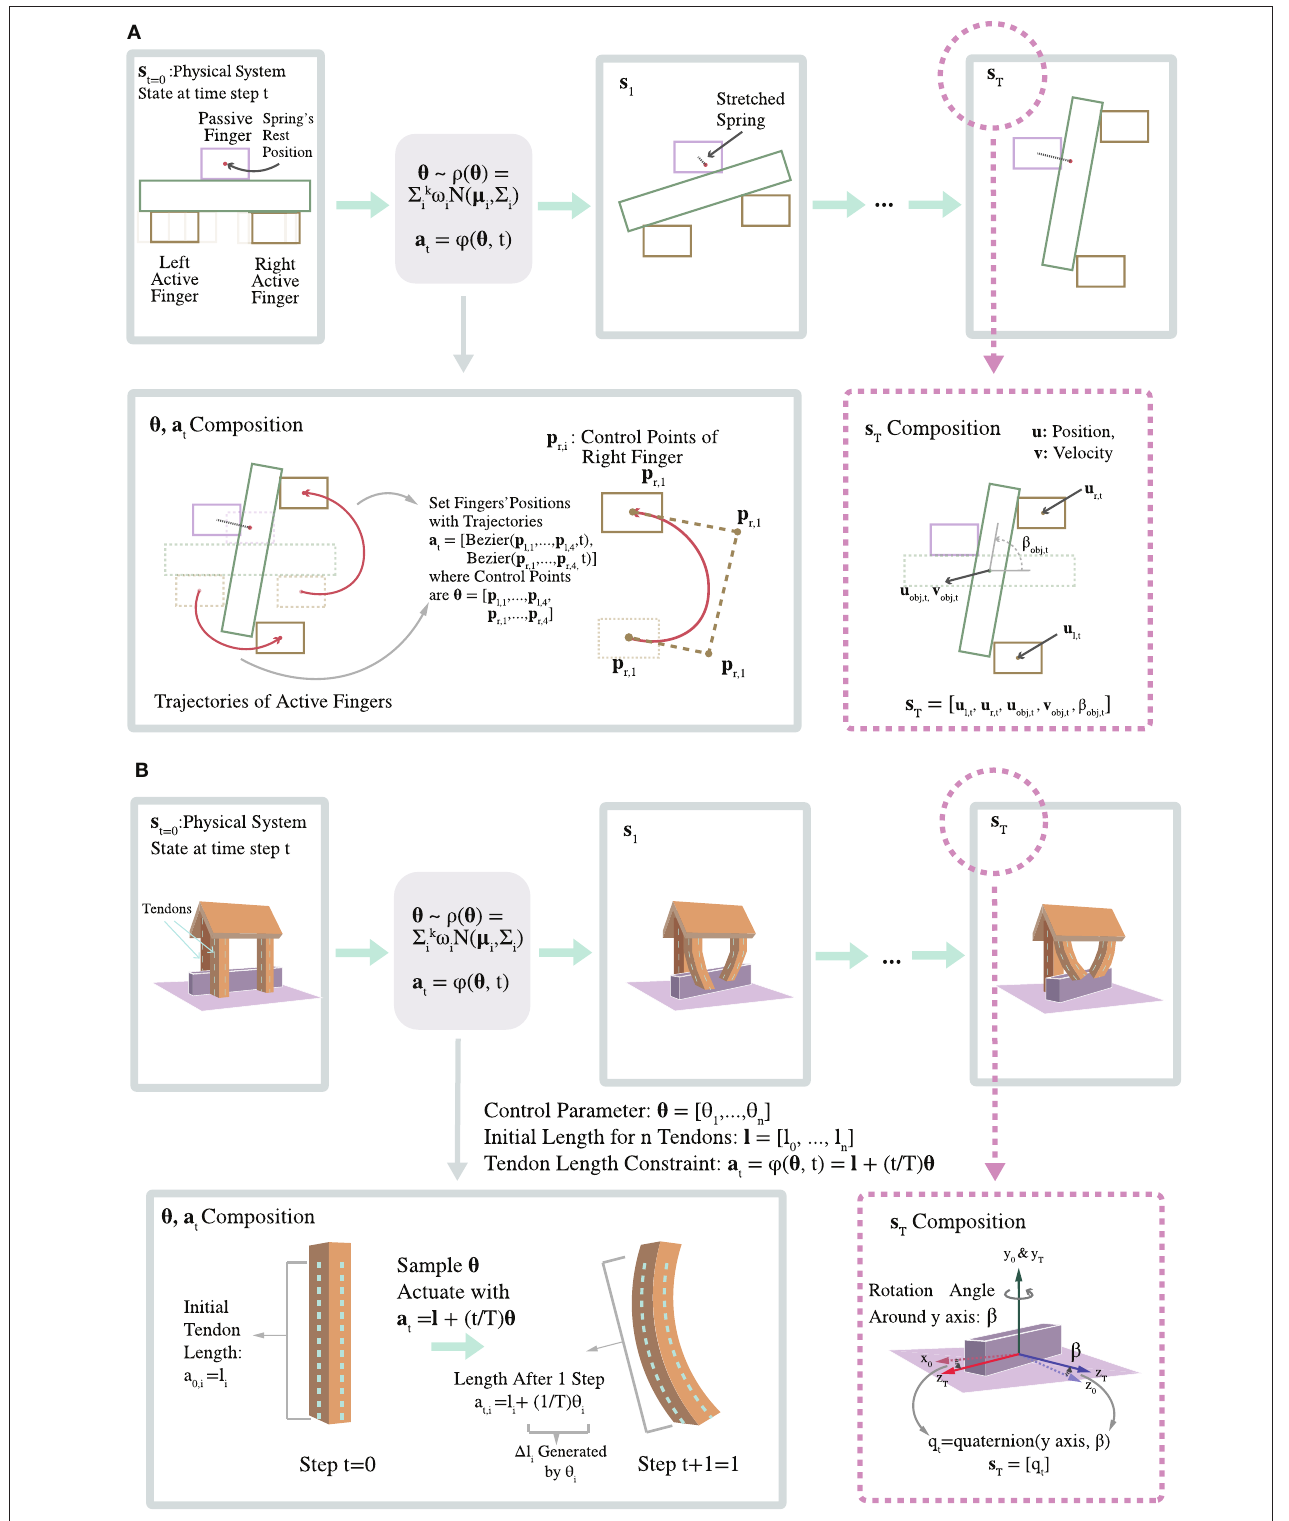
FIGURE 4 | Illustration of 2D and 3D Rotation Tasks (top and bottom, respectively).